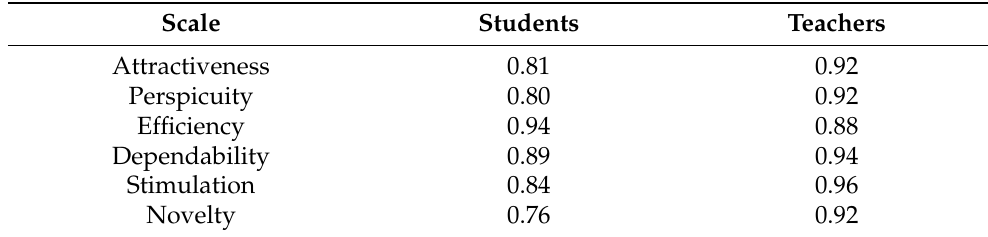
Table 3. Cronbach’s alpha coefficients.